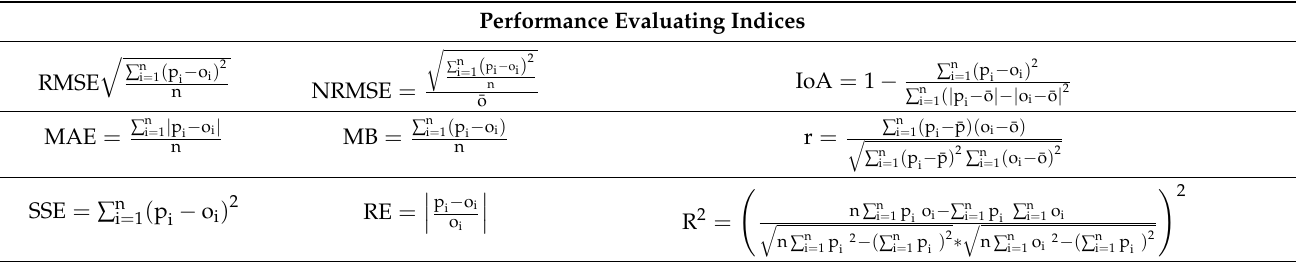
Table 1. Formulae of the indices utilized to evaluate the performance of the examined ANN models. Performance Evaluating